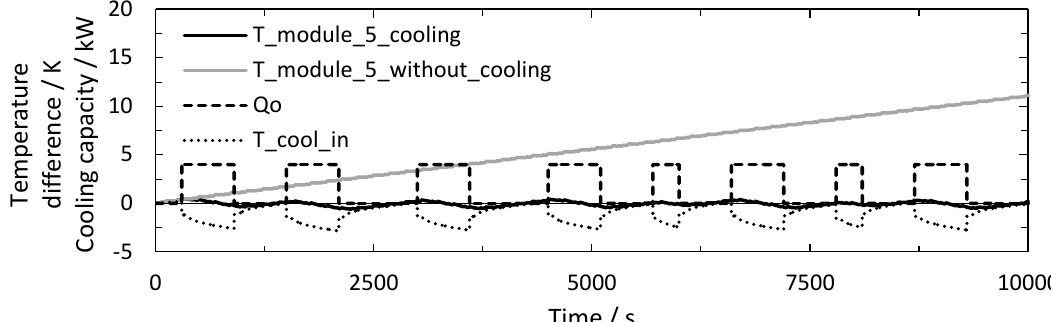
Figure 14. Coolant temperature, coolant capacity, controlled and uncontrolled mean battery cell temperature of module 5 for fifteen repeated sequences of the SORT2. The temperature difference refers to the initial conditions.